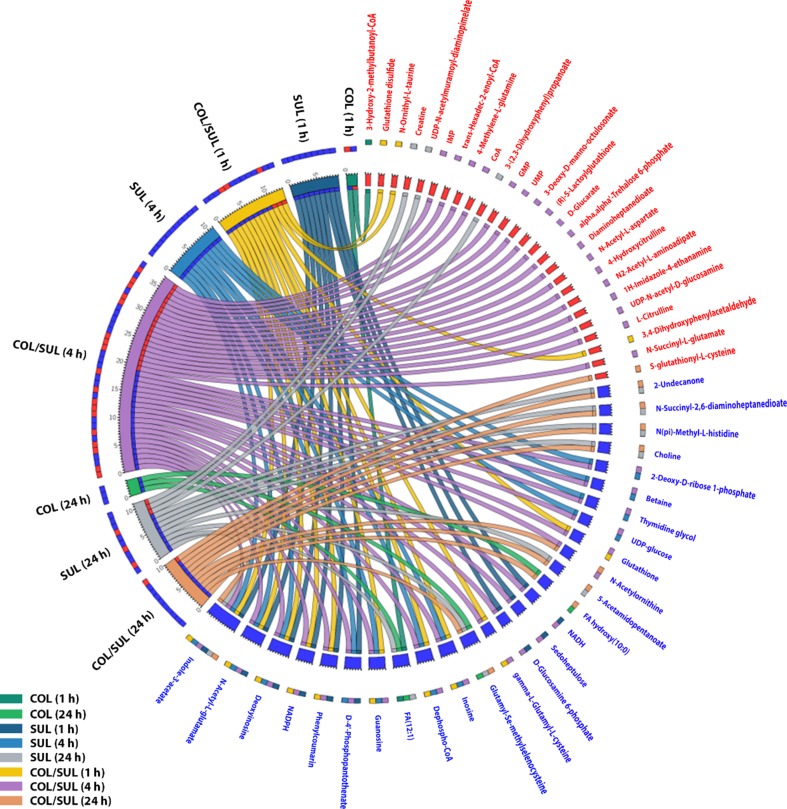
Significantly affected metabolites in A. baumannii AB090342 after the treatments with colistin (COL), sulbactam (SUL), and the combination (COL/SUL) over 24 h. Metabolites with |log2FC| ≥ 2 were chosen for correlation analysis. The bipartite graph shows the correlations of all three treatments at 1, 4, and 24 h (left) and significantly affected metabolites (right). Metabolite names and labels in red indicate unique metabolic changes due to a specific treatment, while those in blue show common metabolic perturbations between at least two conditions.